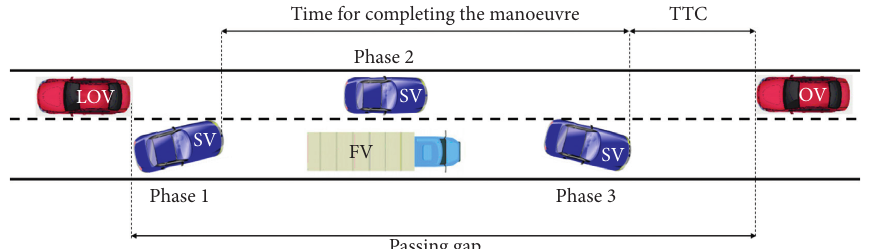
Figure 3: Passing manoeuvre phases (LOV � leading opposite vehicle; OV � opposite vehicle; SV � subject vehicle; FV � front